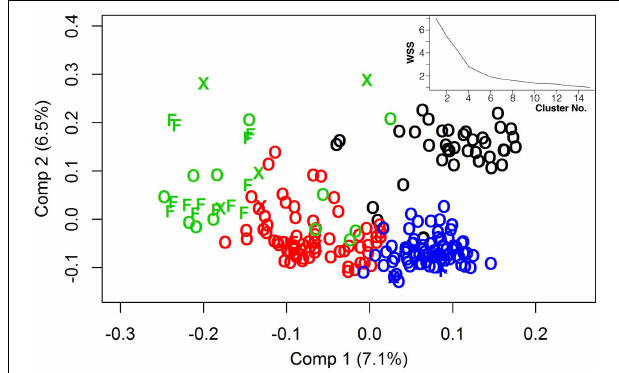
FIGURE 1 | Genetic relatedness of 218 genetically diverse winter-rapeseed lines shown in a principal component analysis regarding the first 2 components. Different clusters were represented by different colors. Winter oilseed rape lines were shown as “O,” winter fodder lines as “F” and others as “X.” Top right: Within-cluster sum of squares depending on the number of clusters applied for k-means clustering.